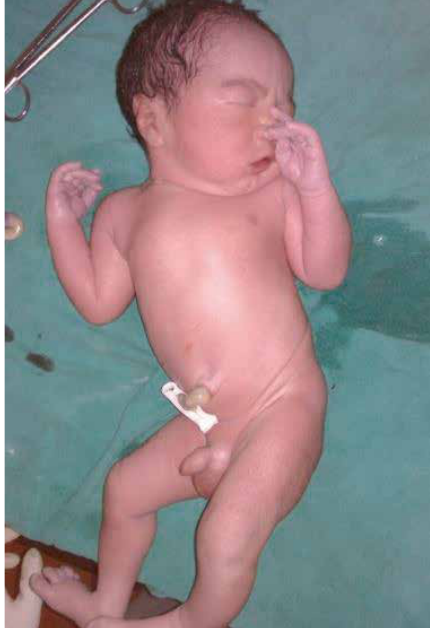
Figure 2: Coexistent healthy baby.